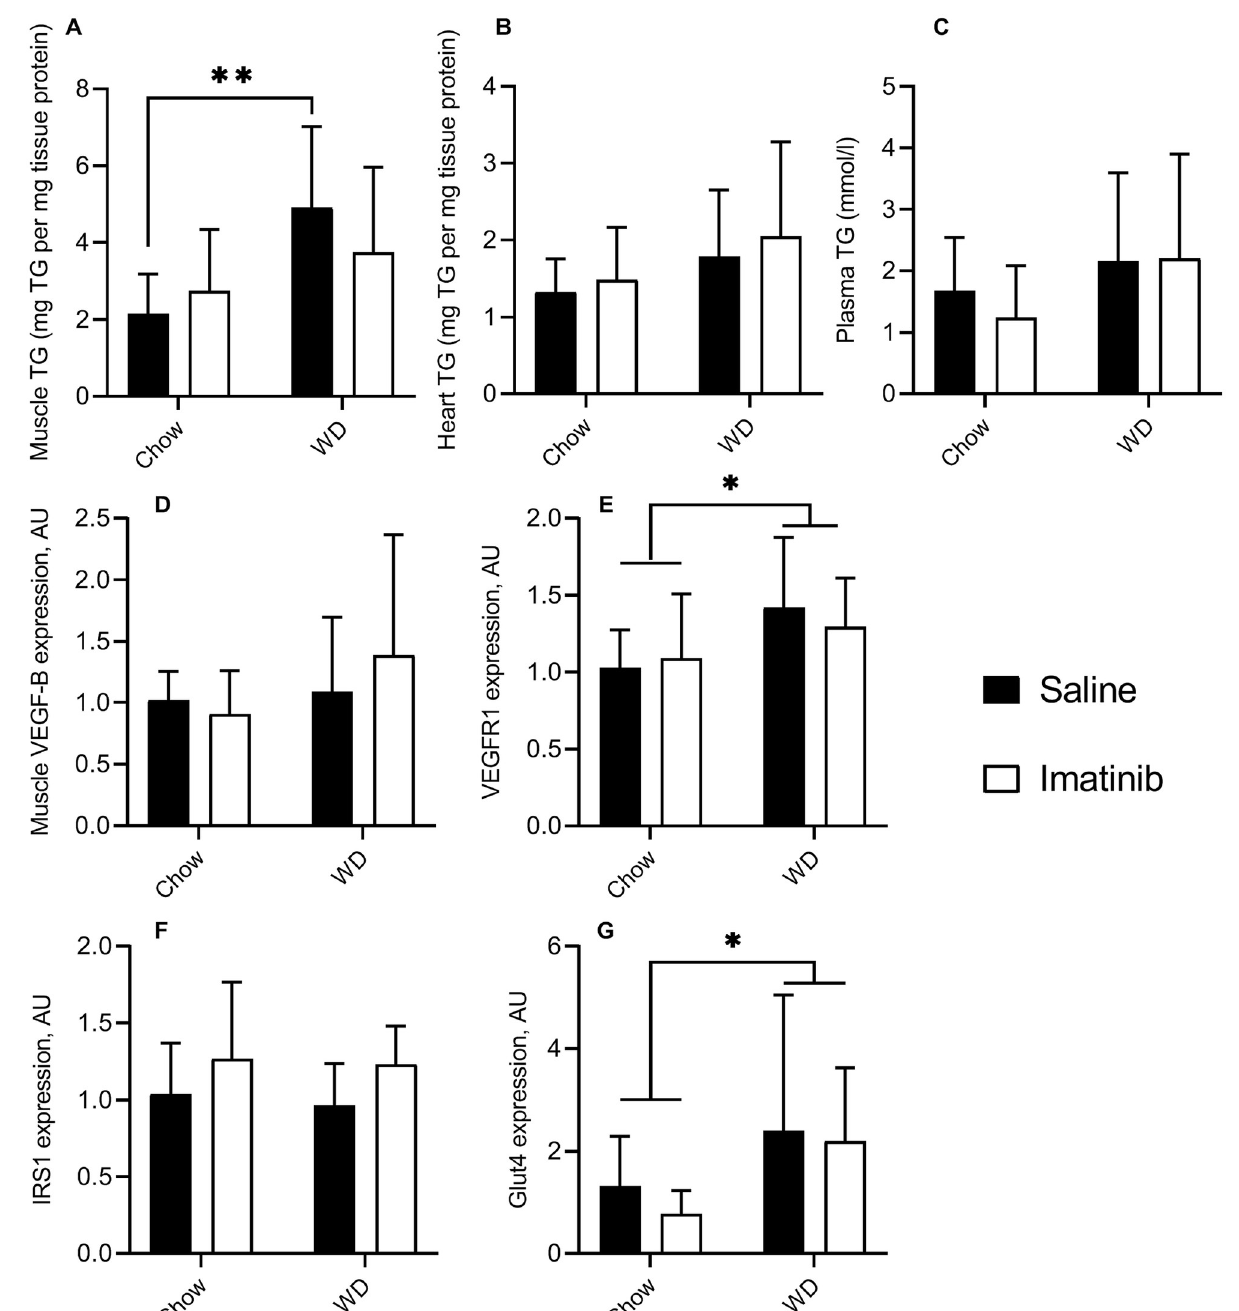
Fig 3. Effect of WD and imatinib on triglyceride (TG) content of skeletal muscle, heart, and plasma and on muscle gene expression. A: TG content in skeletal muscle: WD increased TG content in skeletal muscle as compared to chow ( P = 0.009). Imatinib did not decrease TG content in the chow group ( P > 0.9) and in the WD group ( P = 0.5). B: TG content in heart: WD caused no increase in TG content as compared to chow diet ( P = 0.1). Imatinib caused no effect on TG content. C: TG content in plasma: imatinib did not decrease the TG content in the plasma of WD fed mice. D: Expression of VEGF-B in gastrocnemeus muscle: imatinib ( P = 0.27) and WD ( P = 0.7) did not affect VEGF-B expression. E: Expression of VEGFR1 in gastrocnemeus muscle: WD feeding increased VEGFR1 expression compared to Chow feeding ( P = 0.04), while imatinib did not affect the expression ( P = 0.5). F: Expression of IRS1 in gastrocnemeus muscle: imatinib ( P = 0.08) and WD ( P = 0.7) did not affect IRS1 expression. G: Expression of Glut4 in gastrocnemeus muscle: WD feeding increased Glut4 expression compared to Chow feeding ( P = 0.04), imatinib had no effect on the expression ( P = 0.5). � P < 0.05 and �� P < 0.01 in Bonferroni post hoc test of non-repeated measures ANOVA, a.u. = arbitrary units. N = 8 (number of mice in each